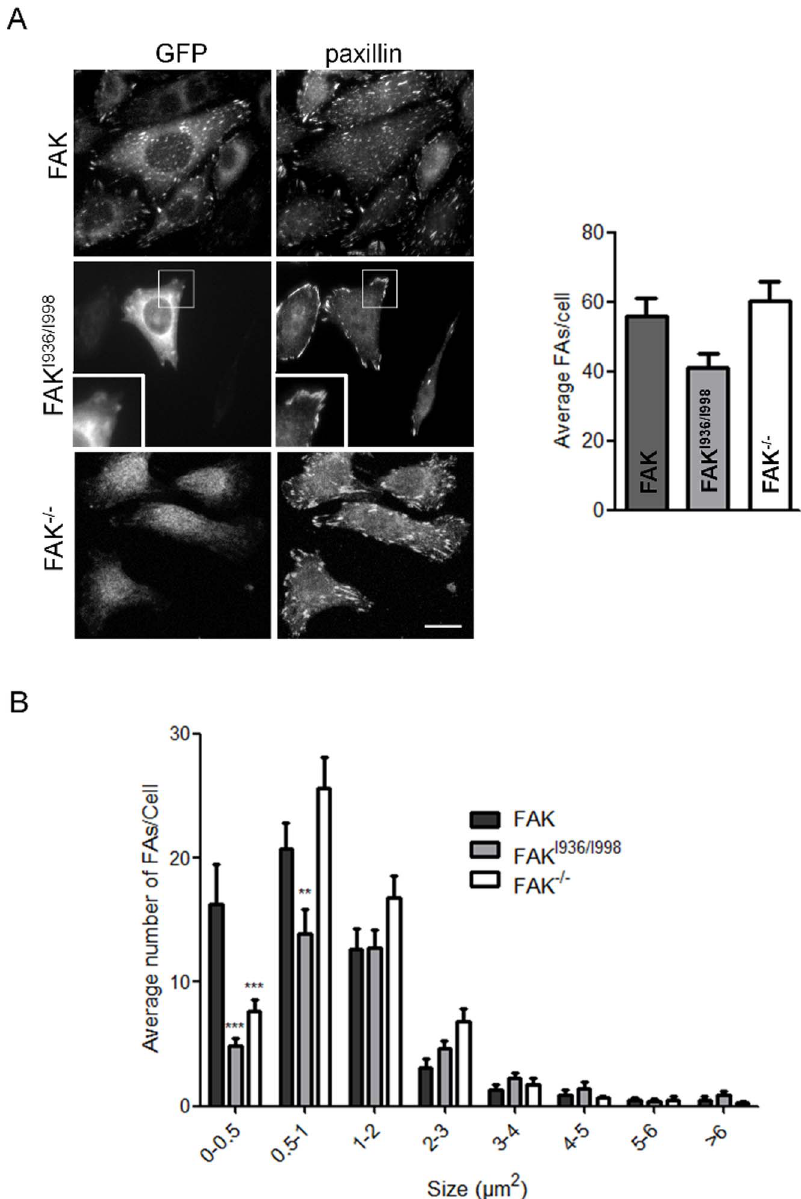
Figure 3. Quantification of focal adhesions in FAK, FAK I936/I998 and FAK -/- cells. (A) Confocal images from fixed FAK -/- cells expressing or not wild-type or mutant FAK-GFP and immunostained for paxillin. Evaluation of paxillin-containing FAs reveals no significant decrease in the number of FAs in FAK I936/I998 cells as compared to FAK -/- and FAK cells (P=0.0602, F=2.958; n=3 independent experiments with 15 to 28 cells and more than 600 FAs counted per condition). Scale bar, 20 m m. (B) Size-distribution of FAs shows a clear deficit of sub-micron sized FAs in FAK I936/I998 (0 , FA , 0.5 m m 2 ***p , 0.001; 0.5 , FA , 1 m m 2 **p , 0.01) and FAK -/- cells (0 , FA , 0.5 m m 2 ***p , 0.001) compared to FAK cells.